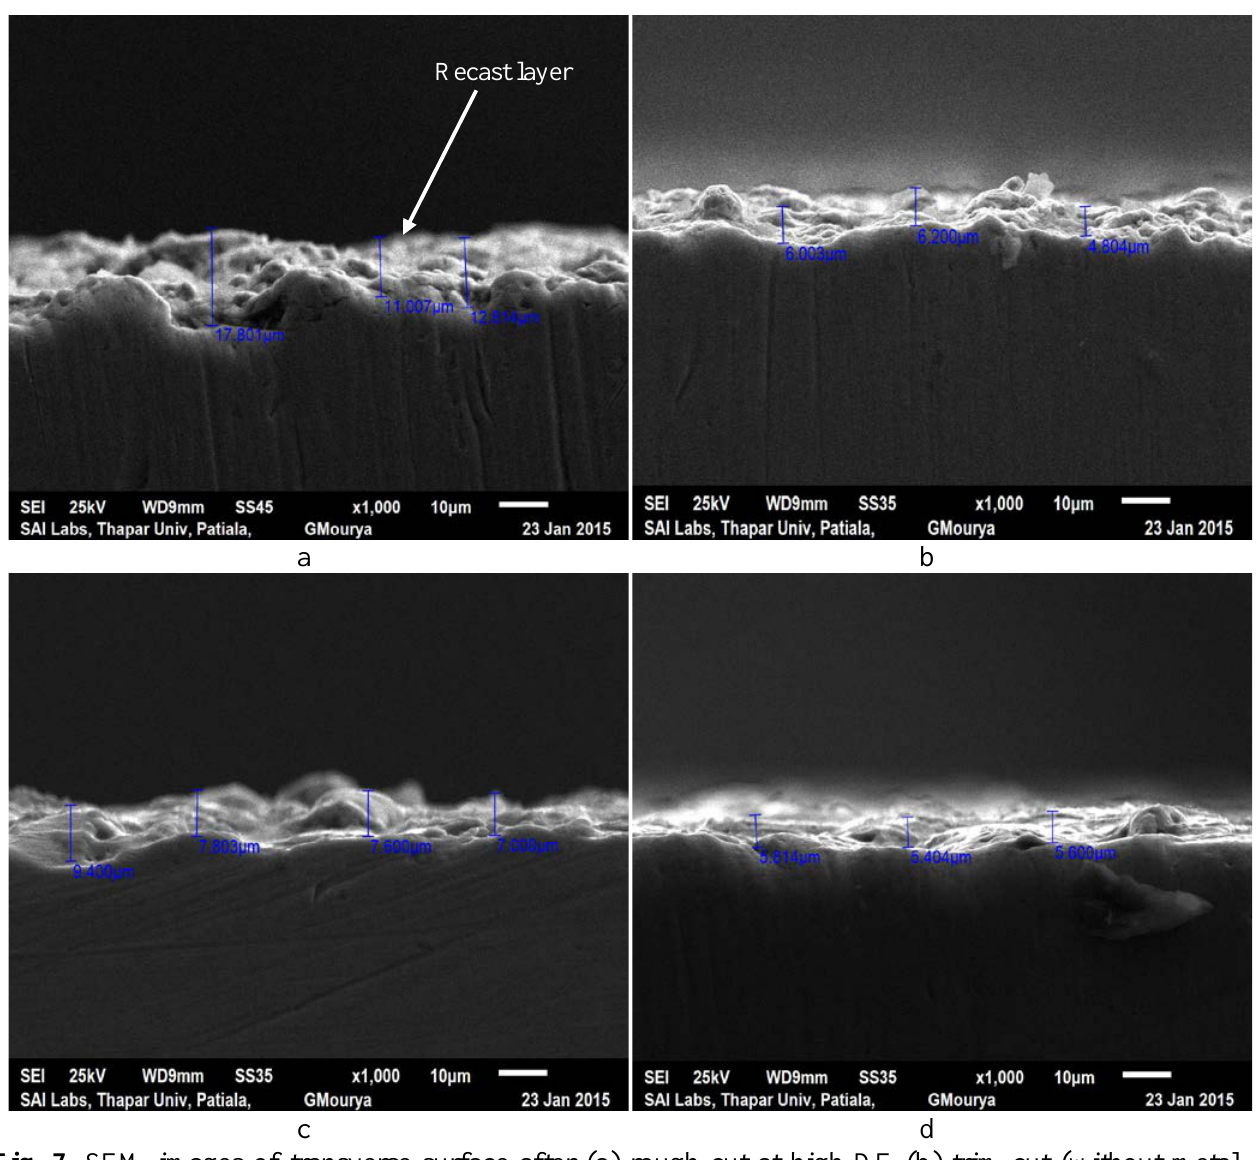
Fig. 7. SEM images of transverse surface after (a) rough cut at high DE (b) trim cut (without metal powder) (c) trim cut using 3g/L Al powder in dielectric fluid (d) trim cut using 3 g/L Si powder in dielectric